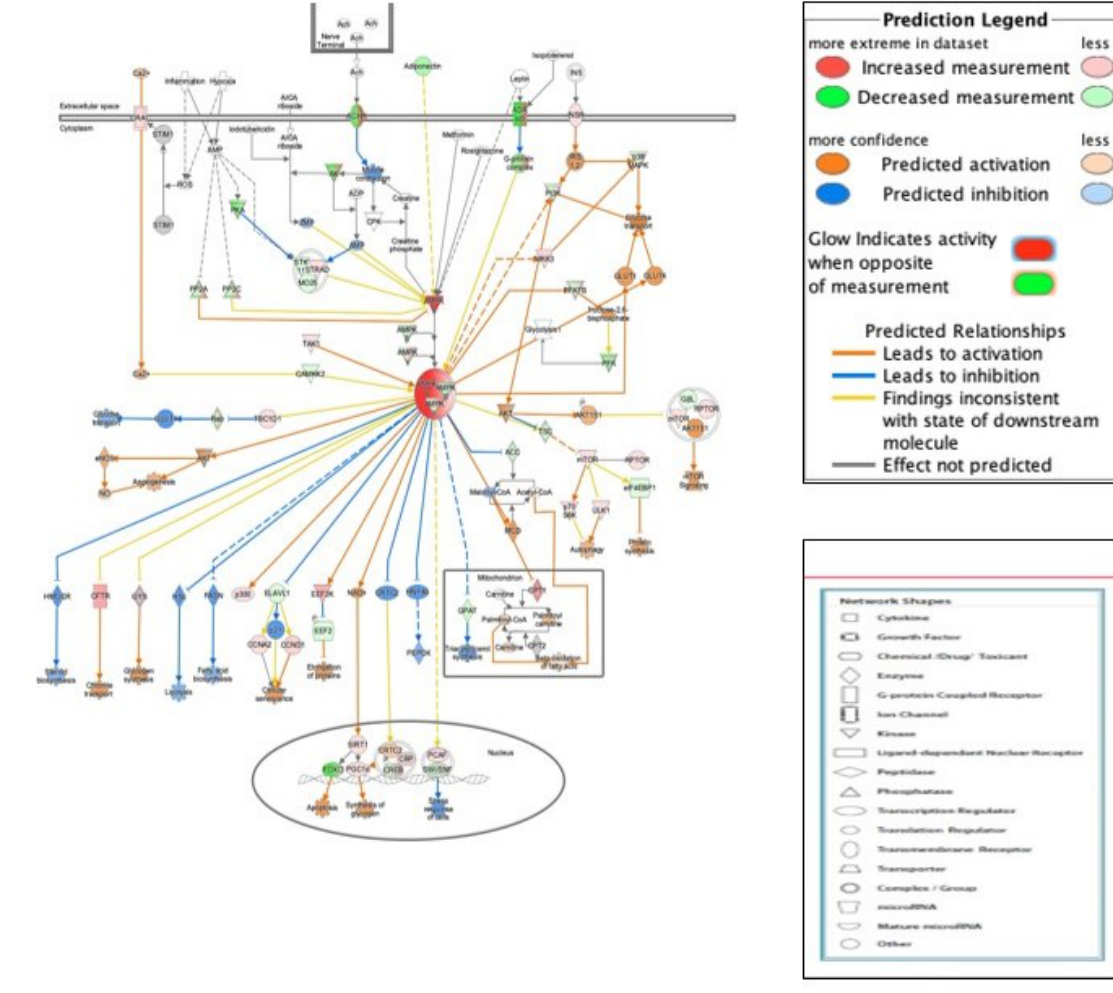
Figure 4. Effect metformin on the AMPK signaling pathway predicted by IPA: the canonical AMPK signaling pathway was overlaid with dataset molecules to predict the downstream effect of AMPK activation. Predicted activation or inhibition of pathways is based on the relationships in the molecular network that represent experimentally observed association between genes and their functions in addition to the literature evidence in the IPA